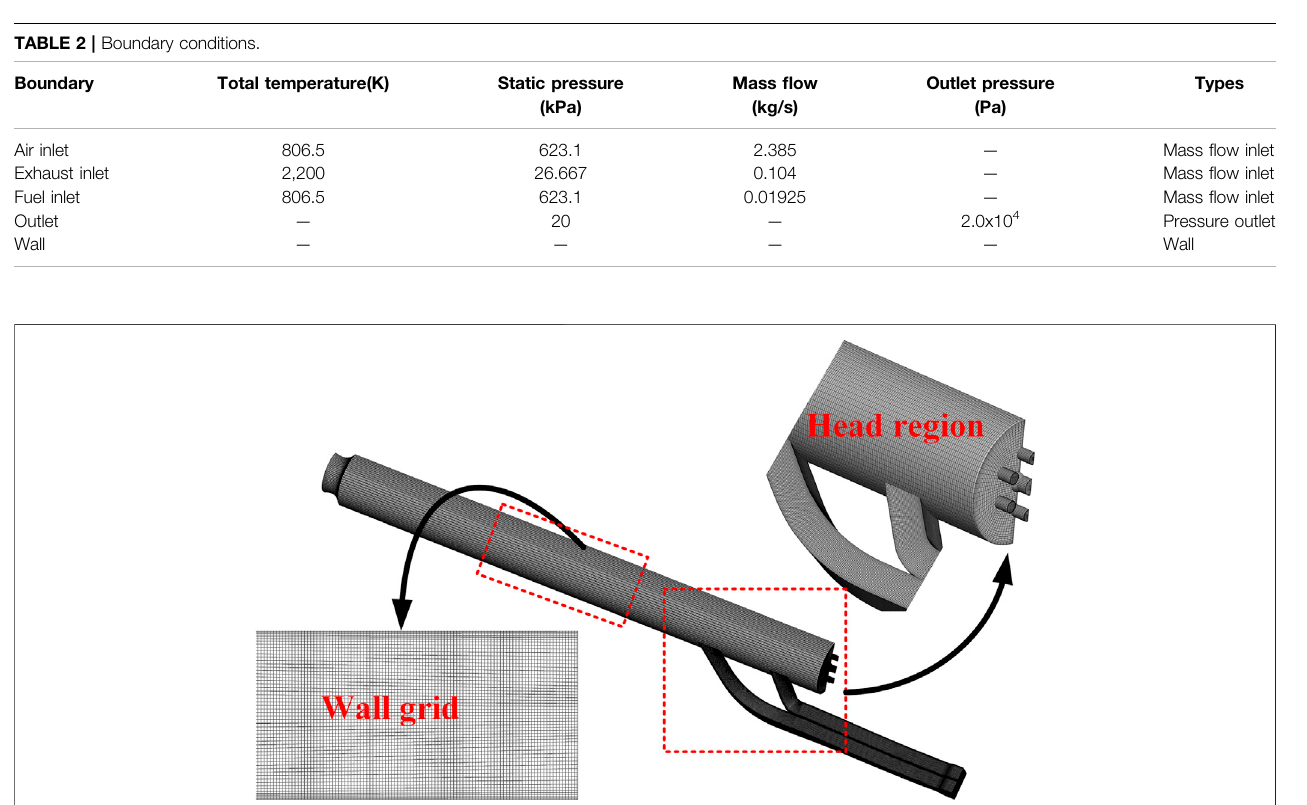
FIGURE 6 | Structured meshes in the typical regions.